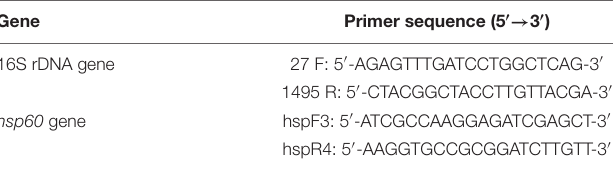
TABLE 1 | Primer sequences for